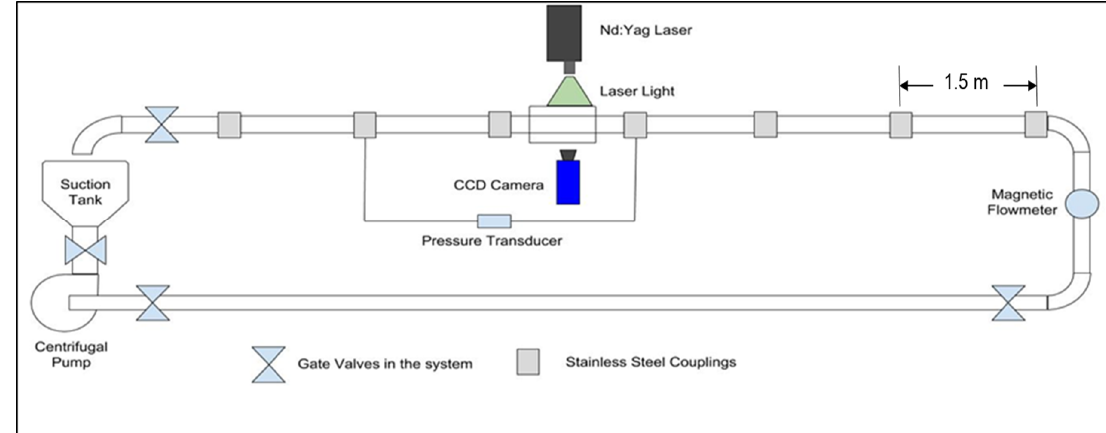
Figure 2. Schematic diagram of the experimental flow loop.